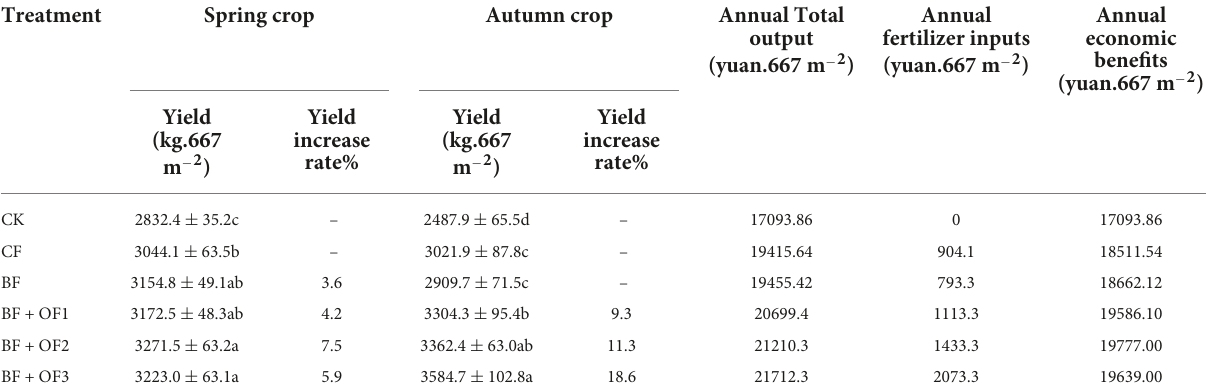
TABLE 2 Cauliflower yield under different fertilization treatments. Treatment